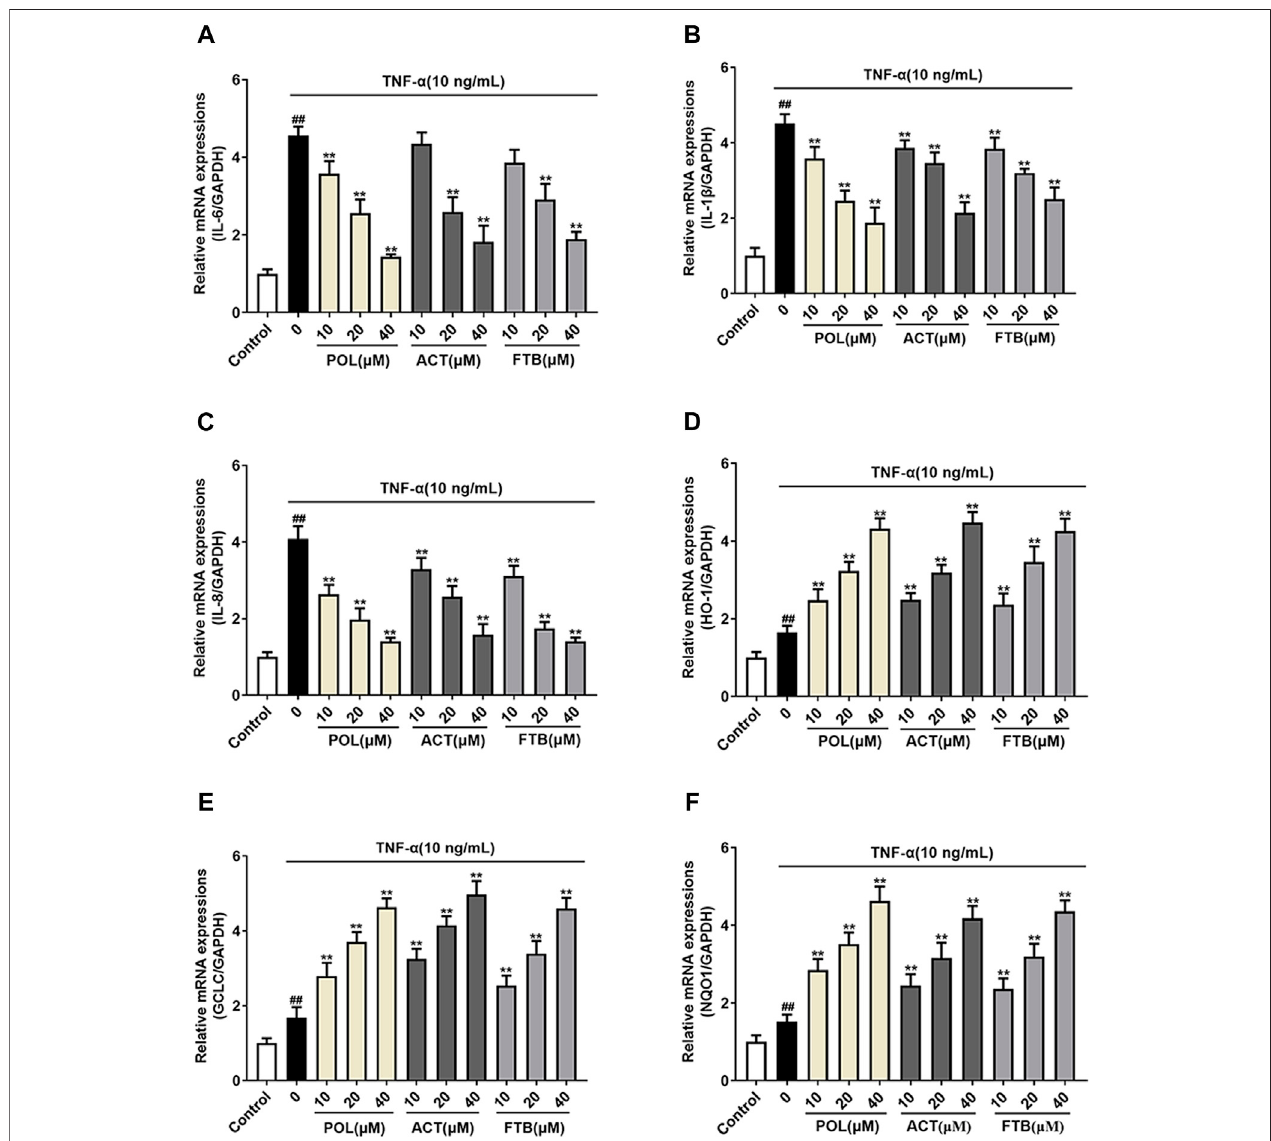
FIGURE4| EffectsofPOL,ACT,andFTBonTNF- α -inducedcellin fl ammationandoxidativestress (A – F) RelativemRNAexpressionlevelsofNQO1,GCLC,HO-1, IL-1 β , IL-6, and IL-8. Values represent the means ± SD ( n (cid:2) 6). ## p < 0.01 vs control; ** p < 0.01 vs TNF- α .